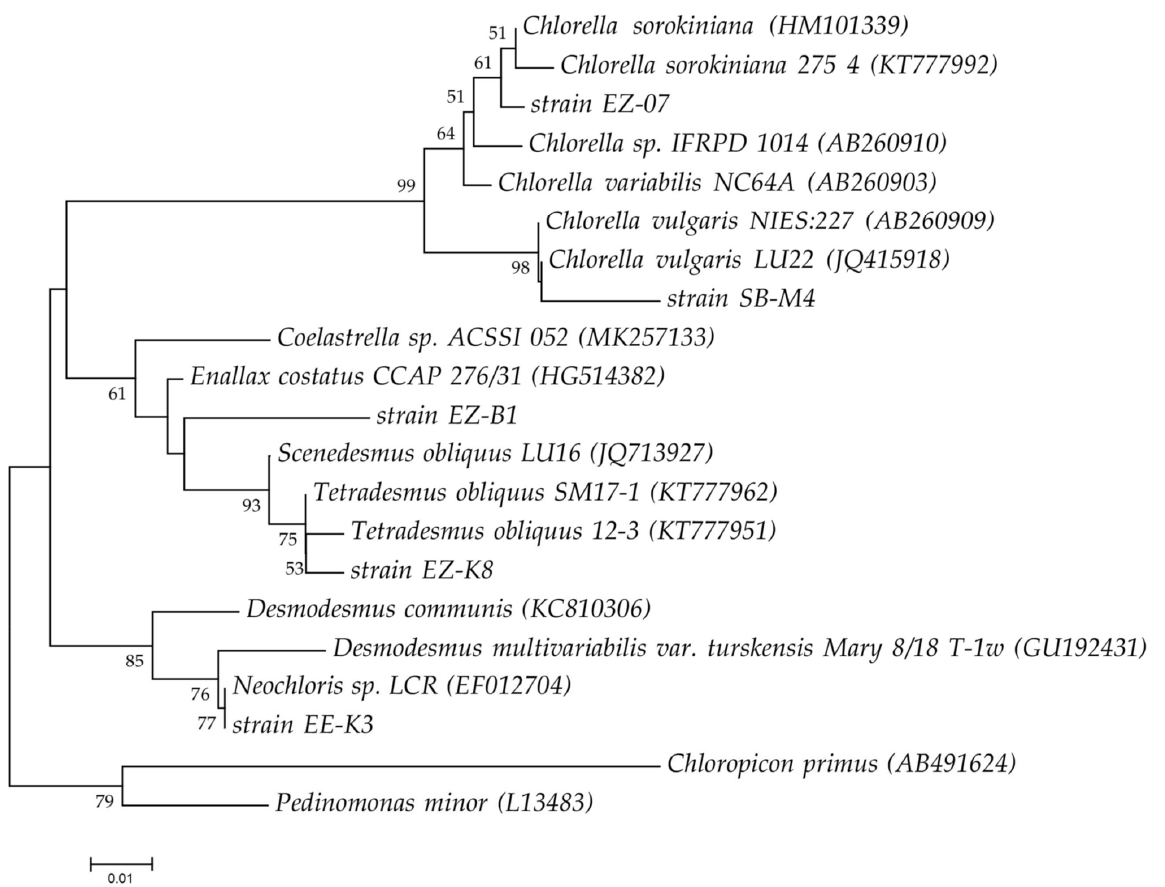
Figure 1. The evolutionary history was inferred using the neighbor ‐ joining method (based on rbcL gene sequences). The percentage of replicate trees in which the associated taxa clustered together in the bootstrap test (1000 replicates) are shown next to the branches. The tree is drawn to scale, with branch lengths in the same units as those of the evolutionary distances used to infer the phylogenetic tree. The evolutionary distances were computed using the Kimura 2 ‐ parameter method and are in the units of the number of base substitutions per site. The analysis involved 21 nucleotide sequences. Evolutionary analyses were conducted in MEGA7 [23]. Chloropicon primus and Pedinomonas minor were used as outgroup references.